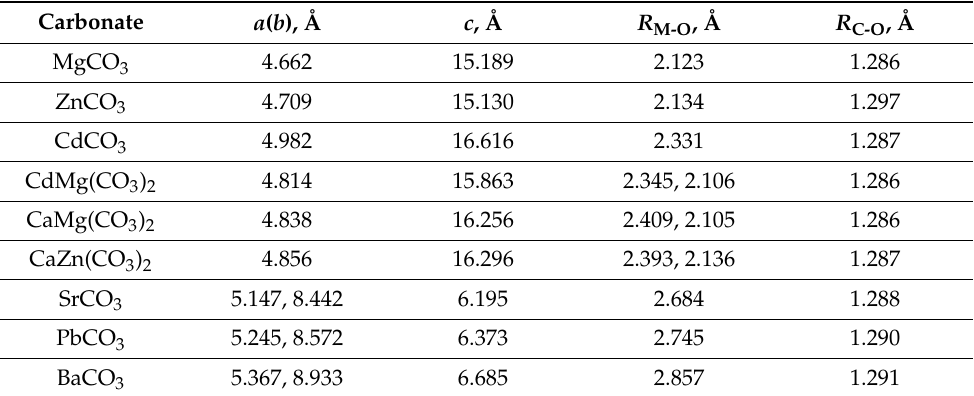
Table 1. Calculated lattice constants a ( a , b for aragonites), c and R M-O distances between metal atom M and oxygen O (M1-O, M2-O for double carbonates M1M2 (CO 3 ) 2 ), R C-O of carbon C and oxygen O.